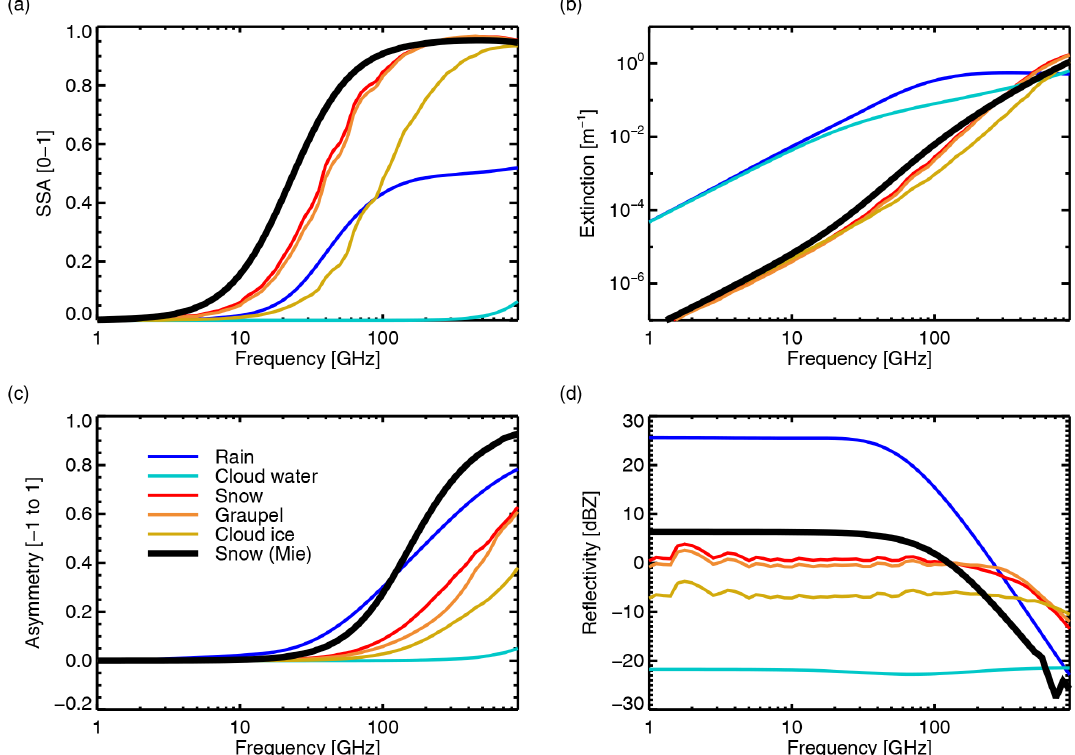
Figure 1. Bulk optical properties: (a) single scattering albedo; (b) extinction; (c) asymmetry; (d) radar reflectivity for the five default hydrometeor types in RTTOV-SCATT (Table 1) plus soft Mie spheres representing snow (density 100kgm − 3 , Field et al. (2007) tropical PSD). Computations have been done for a water content l = 1 × 10 − 4 kgm − 3 and temperatures T = 253K for frozen particles and T = 283K for liquid particles. Frequency steps are logarithmically distributed with 20 points per